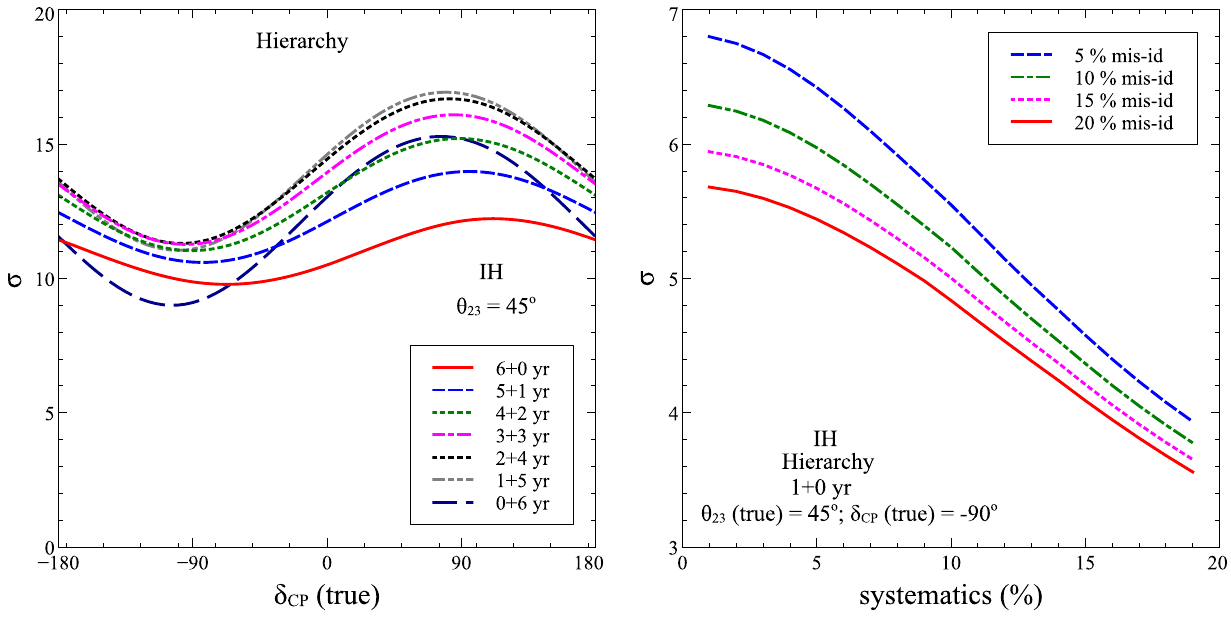
Fig. 10 Hierarchy sensitivity for different combinations for neutrino and antineutrino in IH is shown in the left panel for θ 23 = 45 ◦ . The right panel shows the impact of systematics and backgrounds on the hierarchy sensitivity in IH for θ 23 = 45 ◦ and δ CP = − 90 ◦